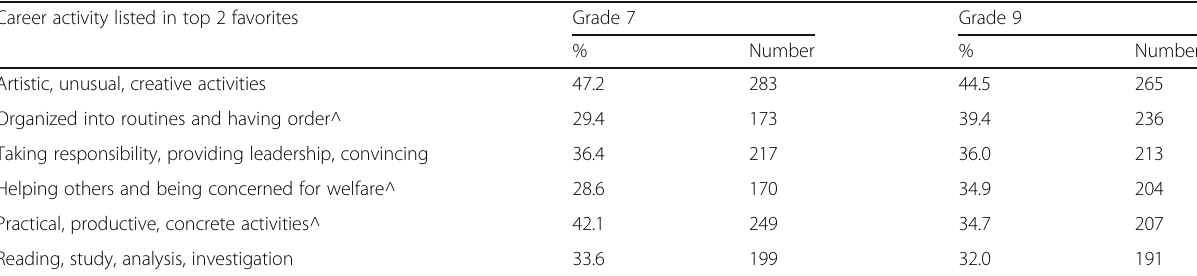
Table 9 Analysis of students ’ favored career activities by grade Career activity listed in top 2